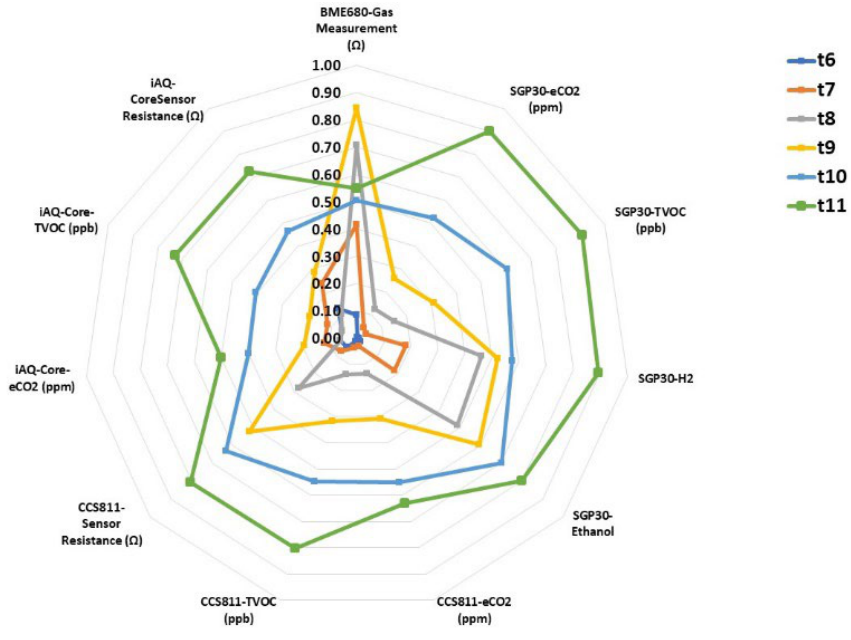
Figure 3. Radial plots of the sensors’ responses to roasted coffee beans submitted to different thermal treatments (t6–t11).